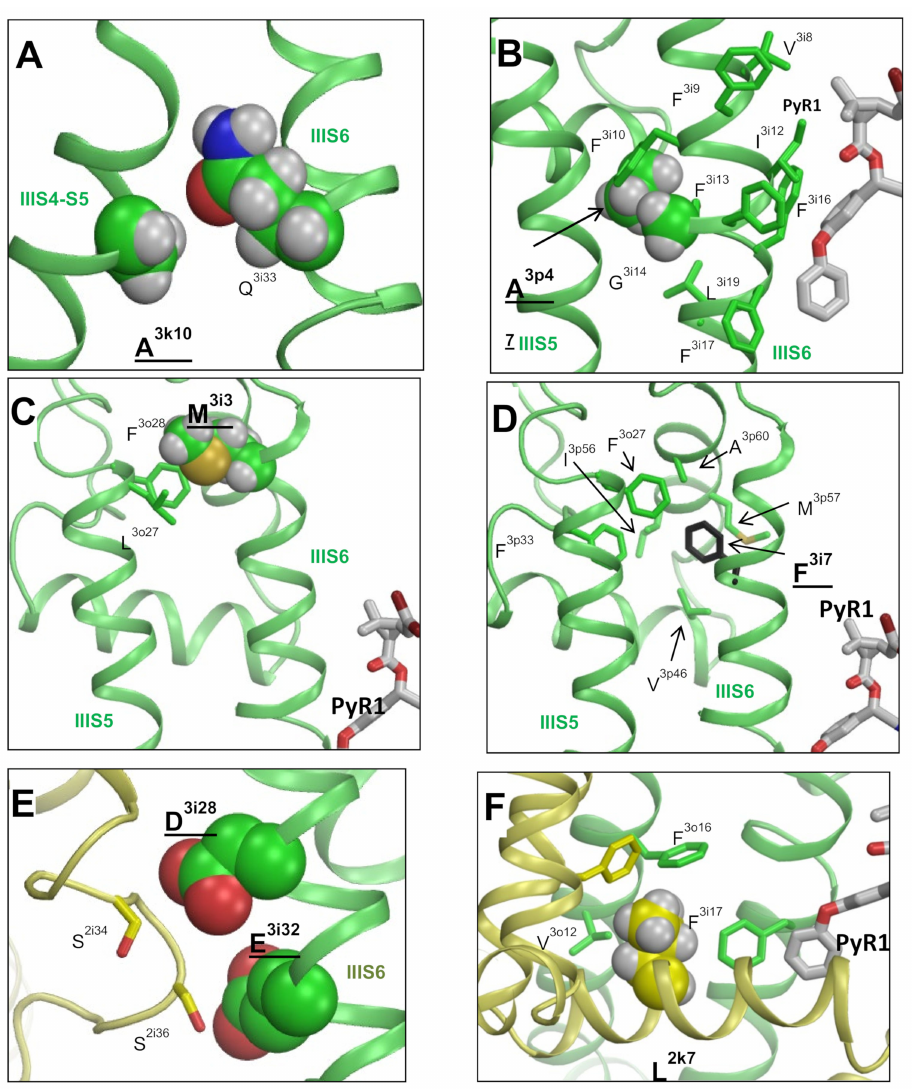
Figure 6. Residues beyond the PyR1 and PyR2 sites form intersegment contacts whose destruction would allosterically affect the action of pyrethroids. Labels of residues that are subject to kdr mutations are bold-underlined (see Section 3.6 for more detail). Labels of residues, which are not subject of kdr mutations, but to their engineered substitutions, are explored in functional studies and are bold-typed. (see Section 3.8 for more detail). Panels ( A – F ) show, respectively, contacts of residues A 3k10 , A 3p4 , M 3i3 , F 3i7 , D 3i28 /E 3i32 and L 2k7